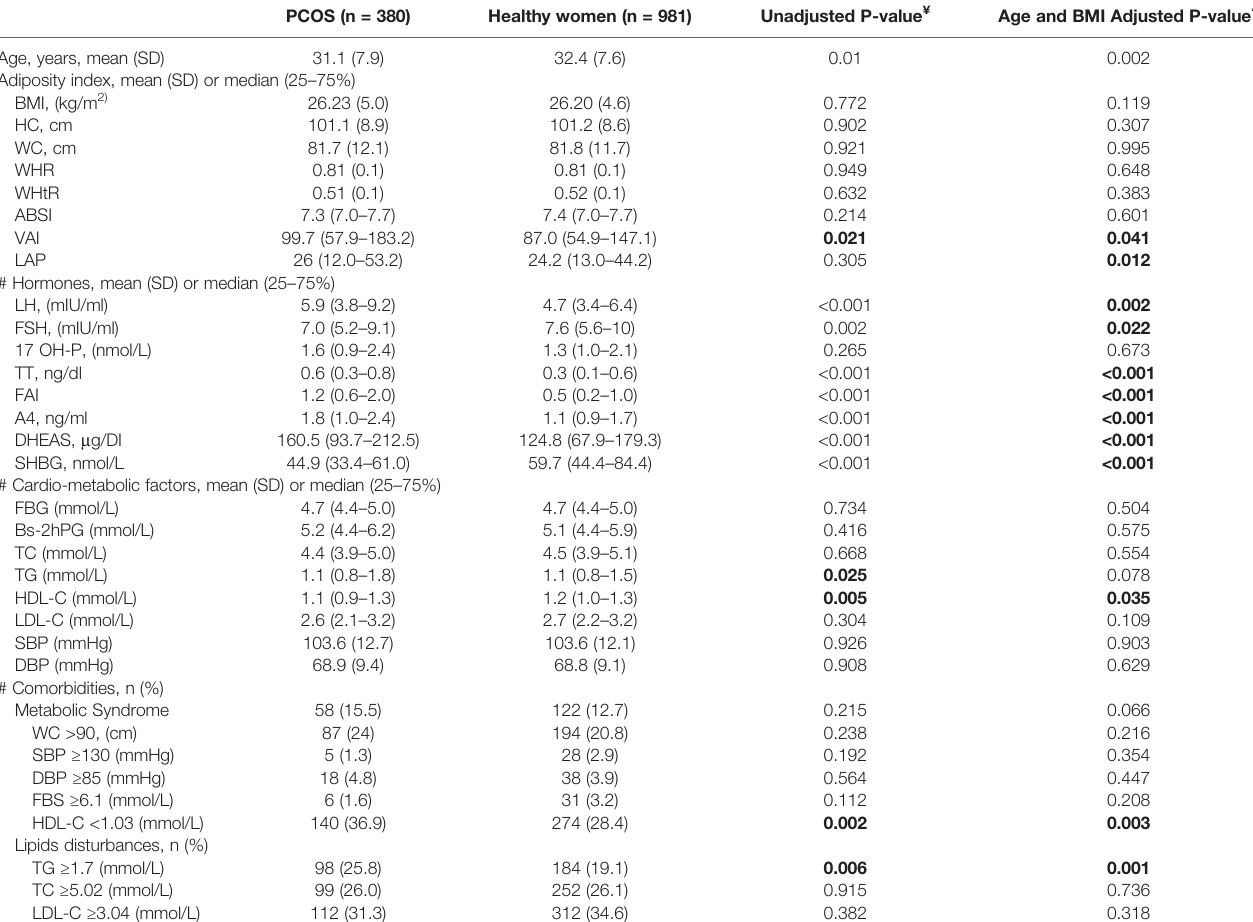
TABLE 1 | Comparison the population characteristics of women with PCOS and healthy women. PCOS (n = 380) Healthy women (n =